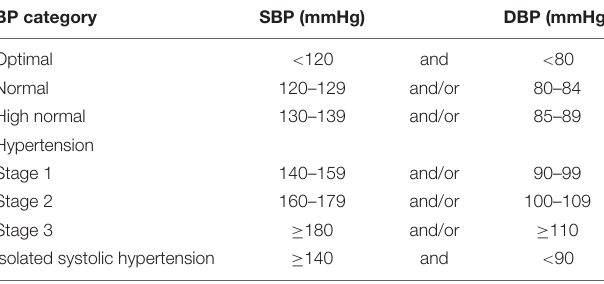
TABLE 2 | Categories of blood pressure levels (mm Hg).